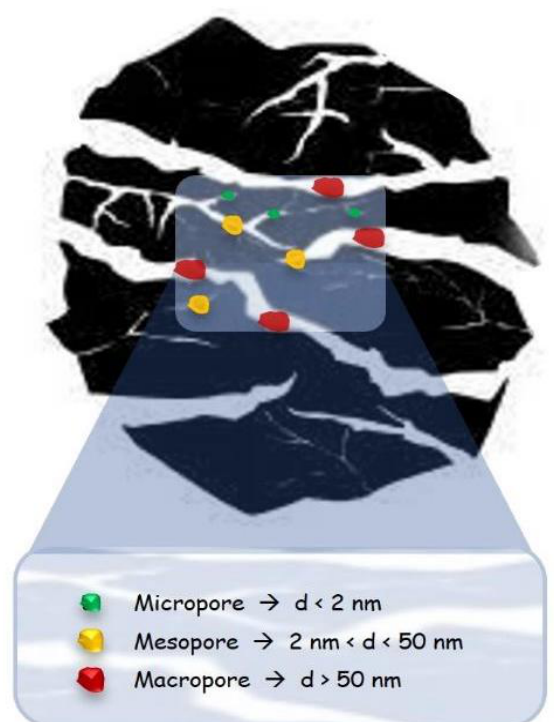
Figure 5. Illustration of different types of pores in ACs particles.